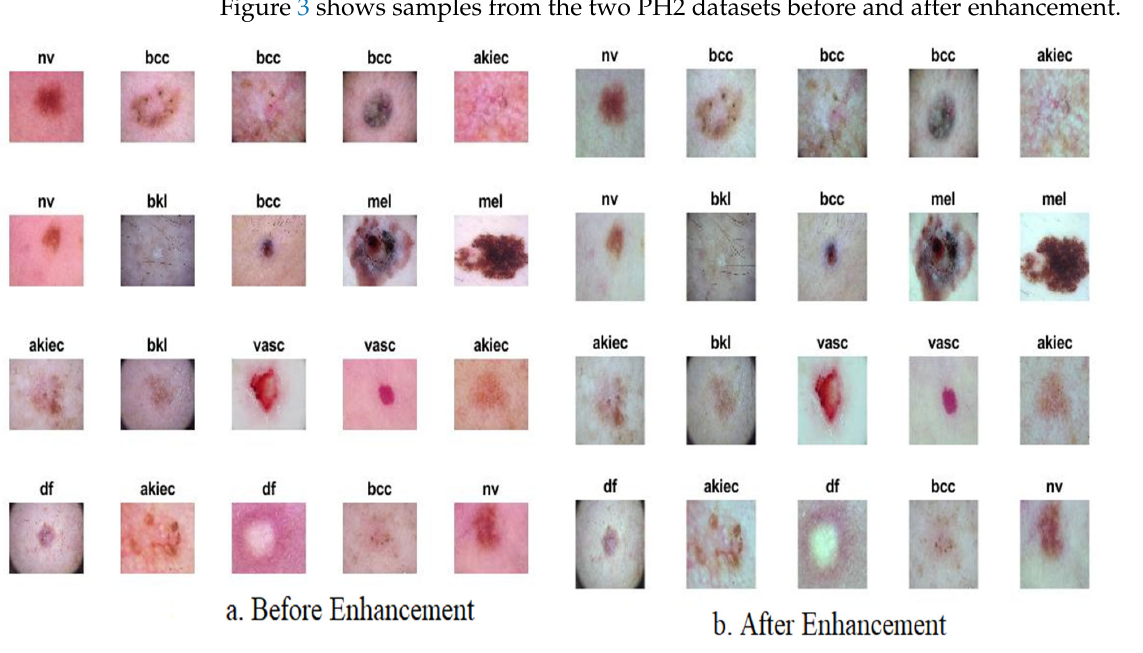
Figure 2. Samples of dermoscopic images for all classes of the HAM10000 data set ( a ) before enhancement and ( b ) after enhancement.